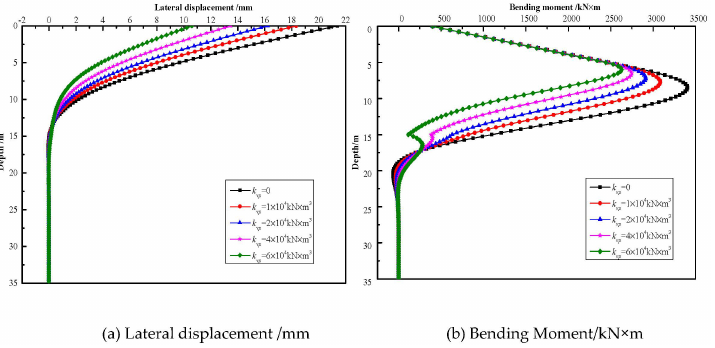
Figure 11. Influence of vertical resistance in passive segment on pile lateral behavior. ( a ) Lateral displacement/mm; ( b ) bending moment/kN ×